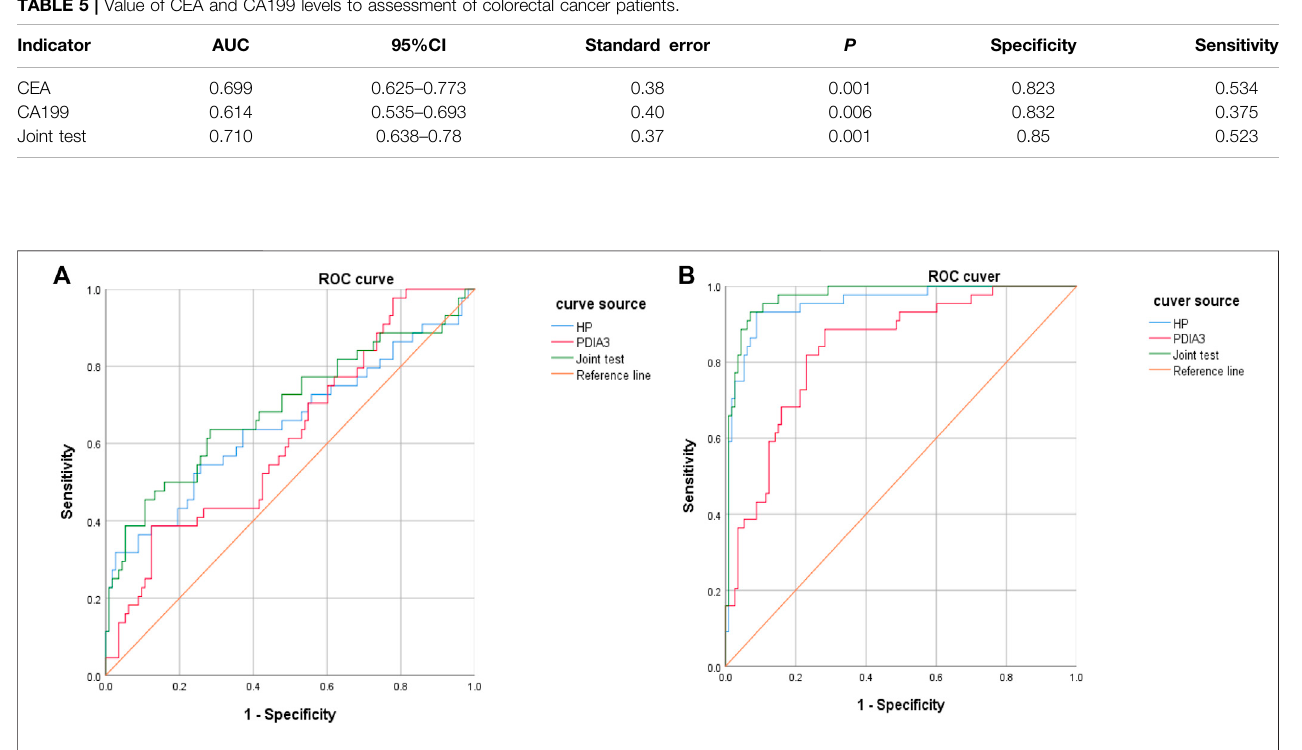
Frontiers in Pharmacology |